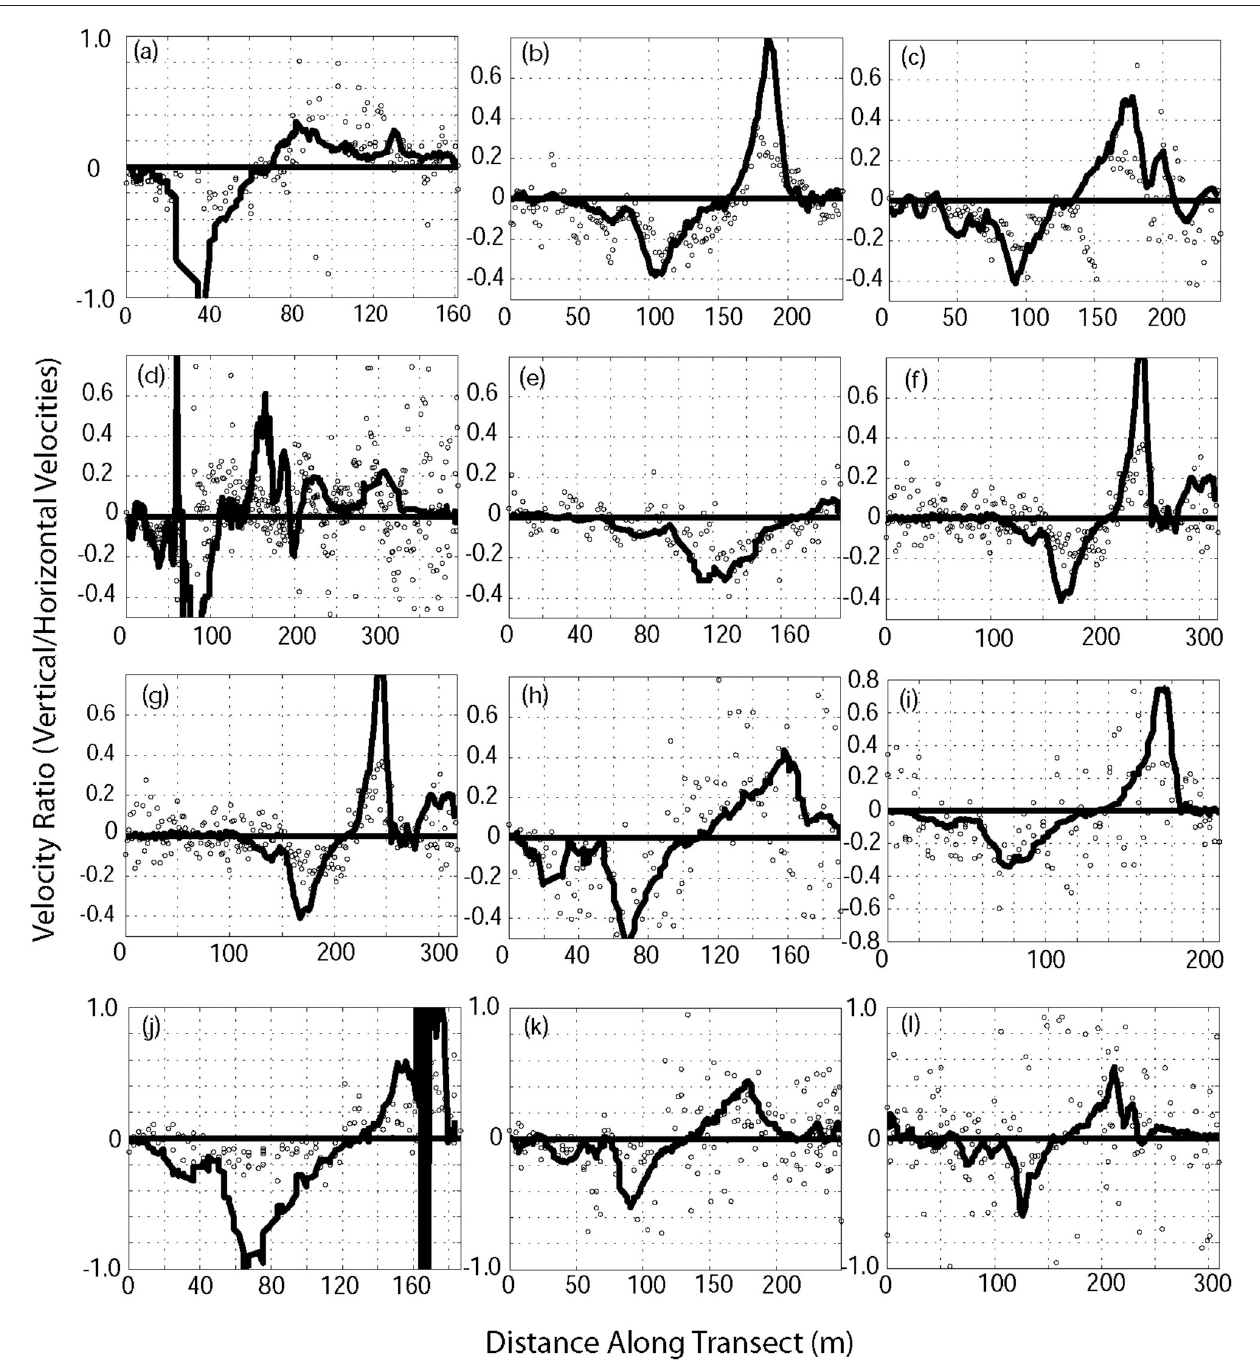
FIGURE 5 | Ratio of depth averaged vertical and north velocities (circles) and bottom slope (lines) for the 12 transects (A–L, No. 1–12 in Table 1). An averaged R 2 values of 0.60 was calculated with a linear regression between the slope and velocity ratios.